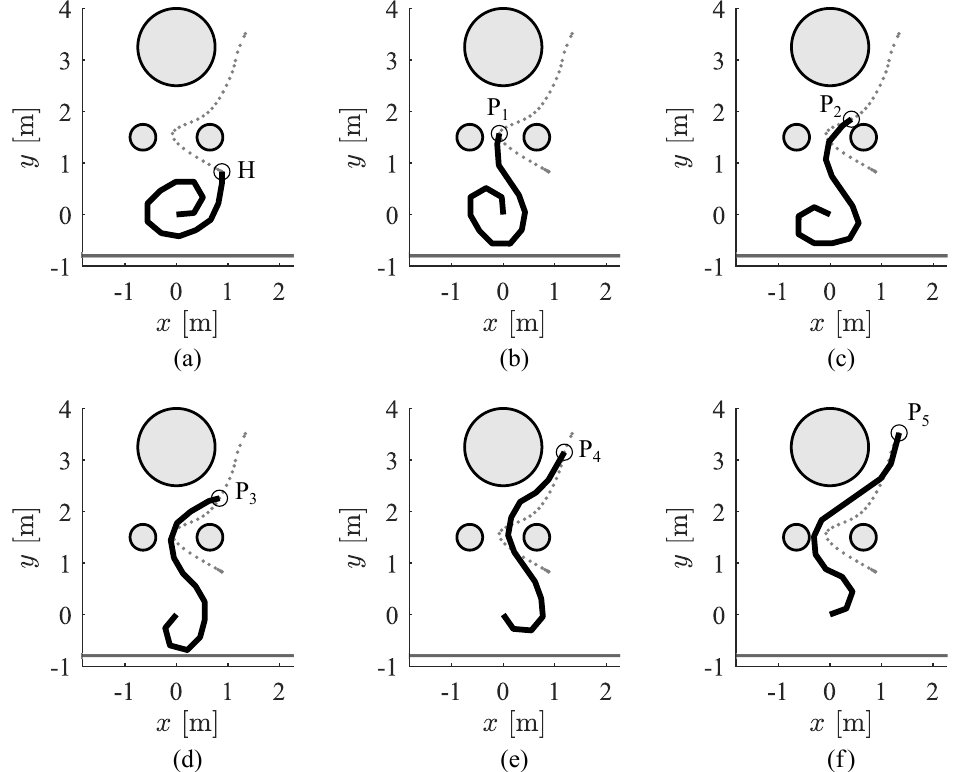
Figure 12. Simulation of SLIM performing the above–described inspection task. ( a ) shows SLIM at its initial configuration, H; ( b ) shows SLIM at P 1 ; ( c ) shows SLIM at P 2 ; ( d ) shows SLIM at P 3 ; ( e ) shows SLIM at P 4 ; ( f ) shows SLIM at P 5 .